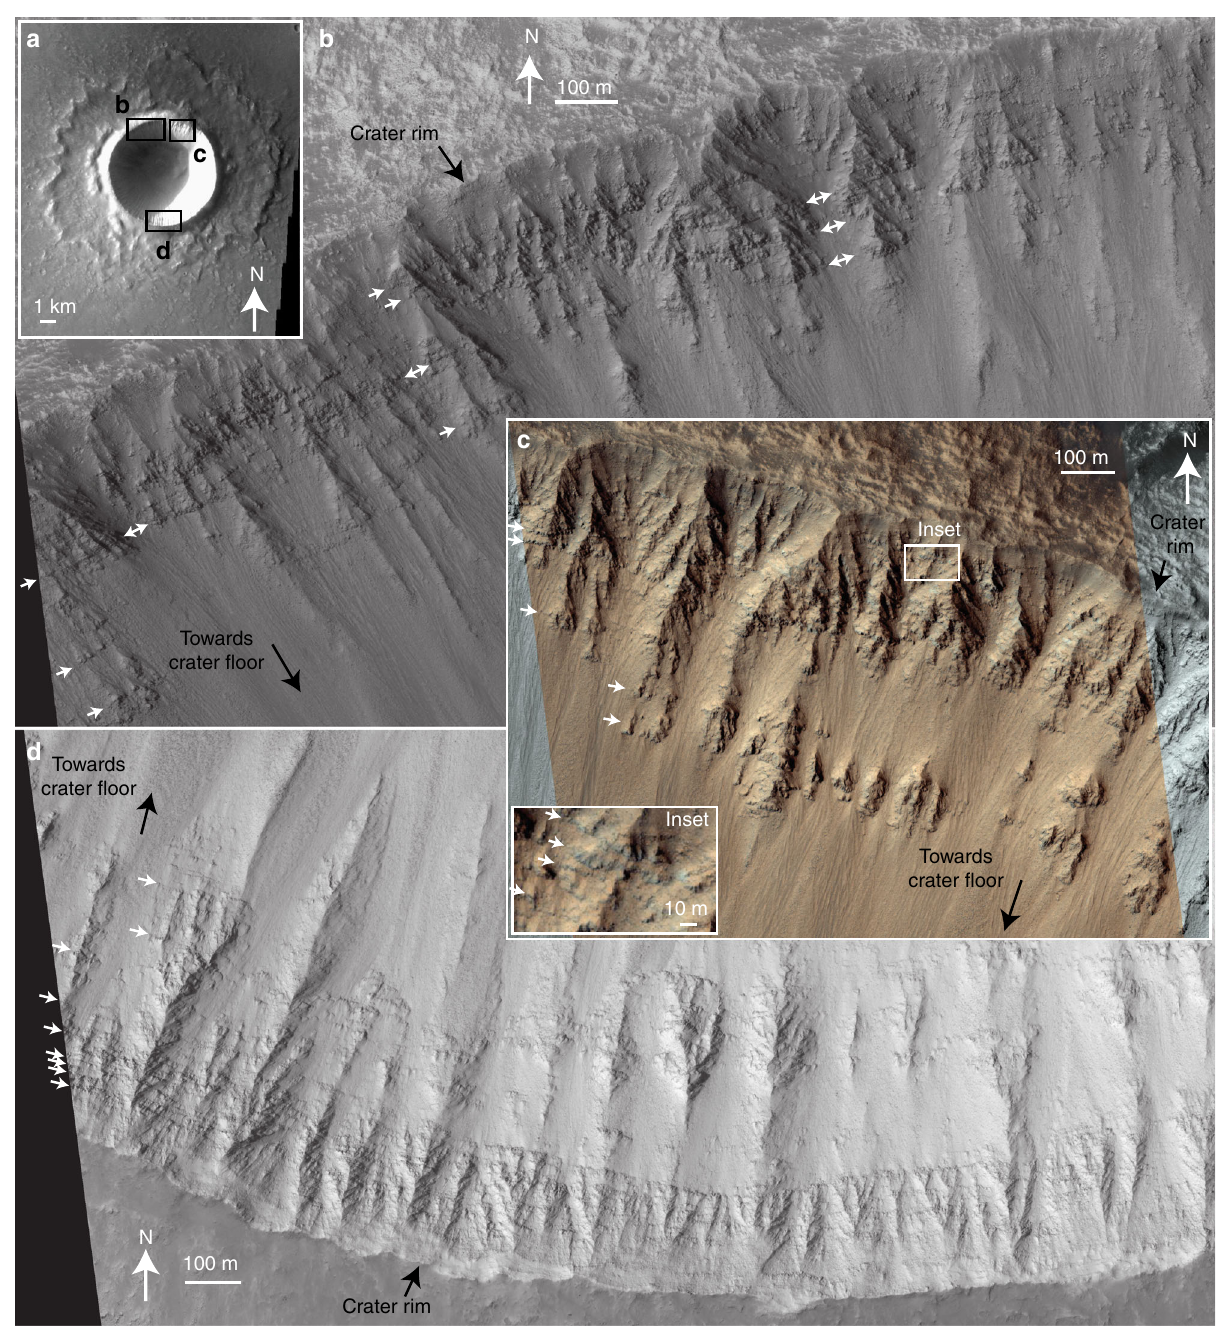
Fig. 7 A potential nakhlite source crater. This crater is located on the Elysium lava plains, to the northwest of the Elysium shield volcano on Mars, at 130.799°E, 29.674°N (Fig. 1). a Overview of the crater, which is 6.5 km in diameter 42 , large enough to have ejected Martian rocks towards Earth 44 . THEMIS image V13713007, Band 3, NASA/ASU. Black rectangles indicate the locations for subsequent images. b – d Detail of the northwestern, northeastern and southern crater rim, respectively, representing parts of HiRISE image ESP 017997_2100, NASA/JPL/University of Arizona. These images show numerous sub-horizontal layers, which are interpreted as lava fl ows (e.g., ref. 35 for similar features elsewhere on Mars). White arrows indicate prominent layers; see inset for detailed view. Solar illumination is from the west in all